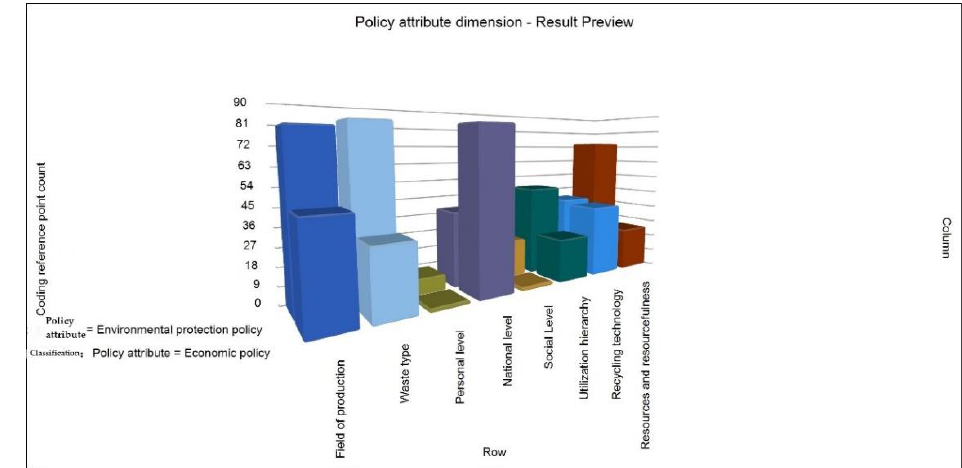
Figure 6. Counting Chart Of Matrix Coding Reference Points Under Policy Attribute Dimension.